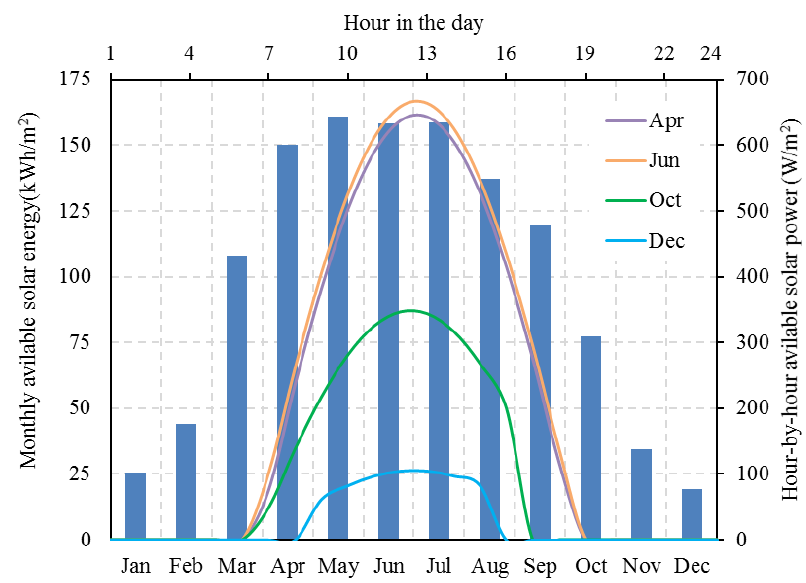
Figure 4. Hourly and monthly available solar energy per square meter on the inclined surface (47 inclination angle and 188 azimuth angle).